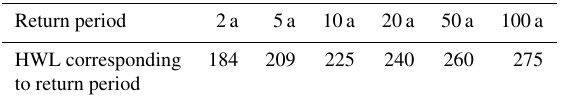
Table 8. Warning water level value of the shore section in Zhifu District, Yantai City, Shandong Province, China (unit: